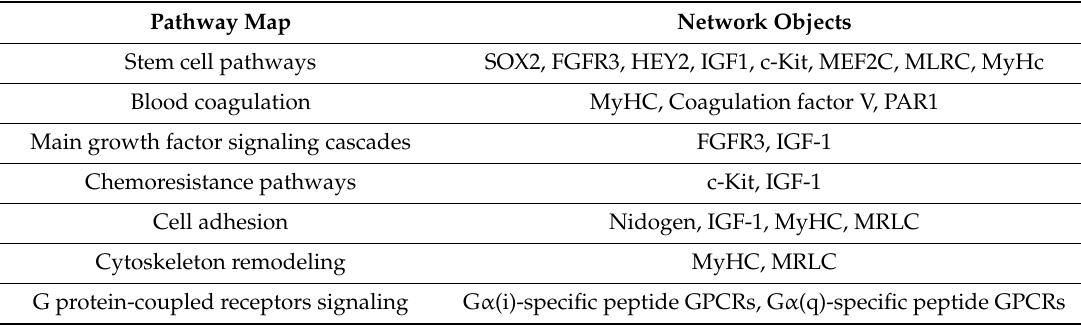
Table 2. Pathways modulated by B4GALNT2 expression.